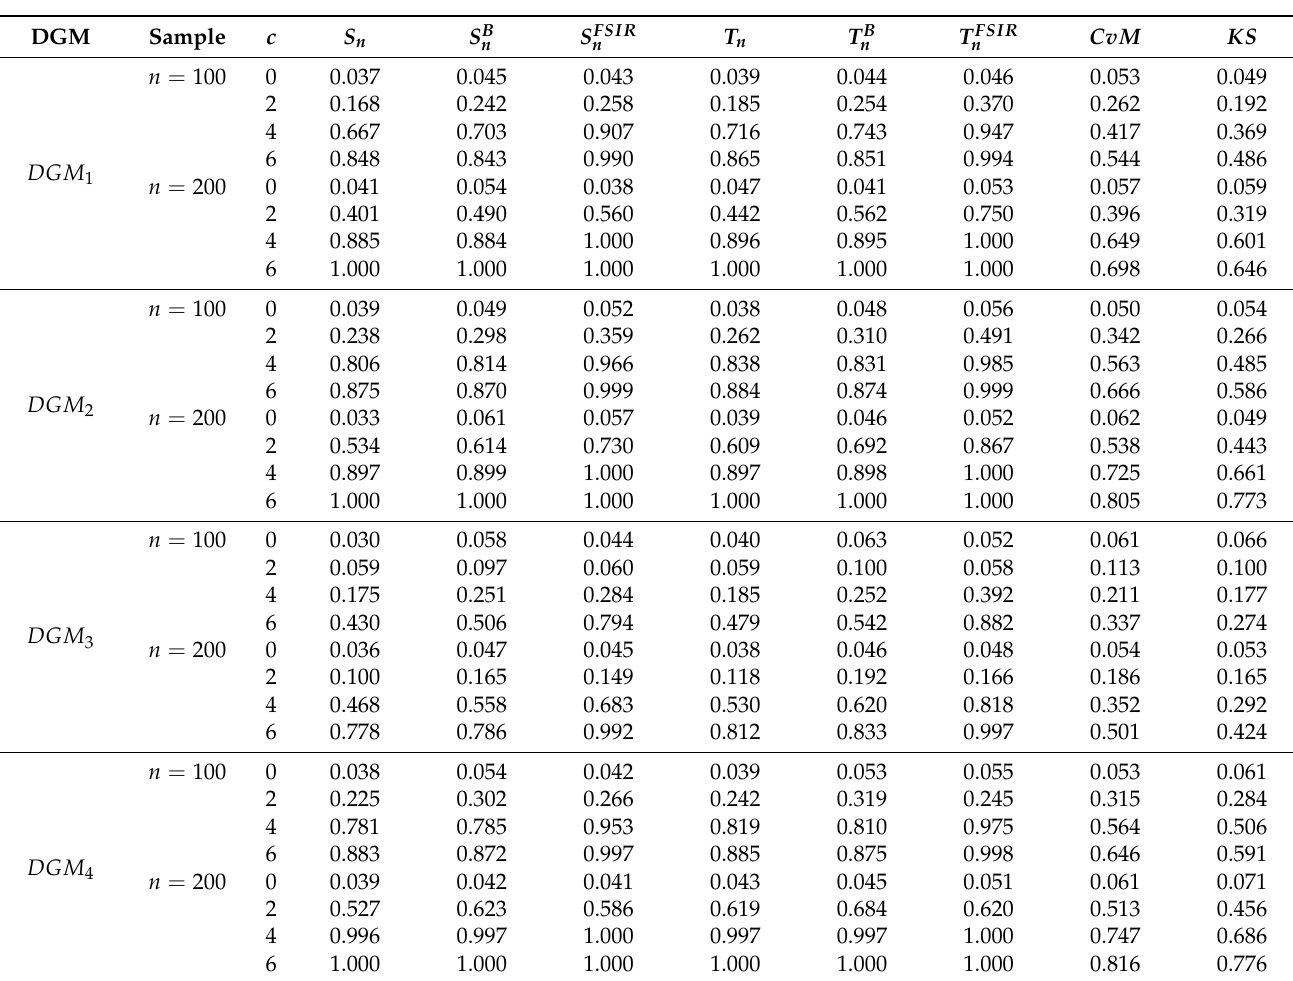
Table A2. Empirical sizes and powers of test statistics under four DGM in Example